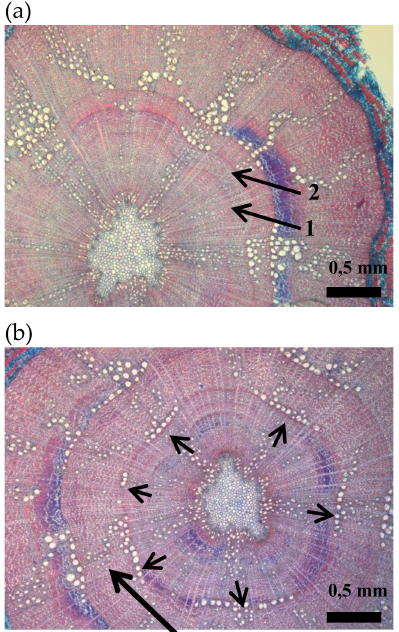
Figure 1. Cross sections of oak seedlings: ( a ) intra-annual density fluctuation (arrow n ◦ 1) in the secondary xylem of the first growing season. Arrow n ◦ 2 indicates the year ring border between the first and the second growing season. ( b ) Cross section indicating a dendritic pattern of latewood vessels in the second growing season (long arrow) and a 50% of vessel ring closure at the onset of the earlywood in the second growing season (short